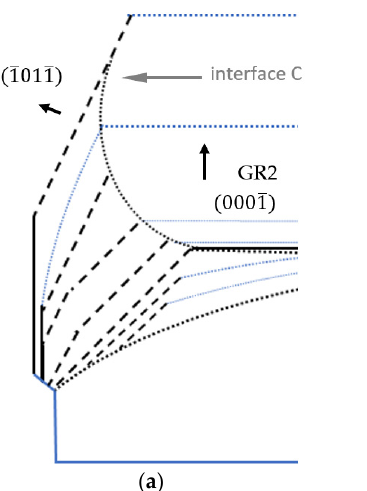
(cid:0) (cid:1) 1210 plane and ( b ) view on the